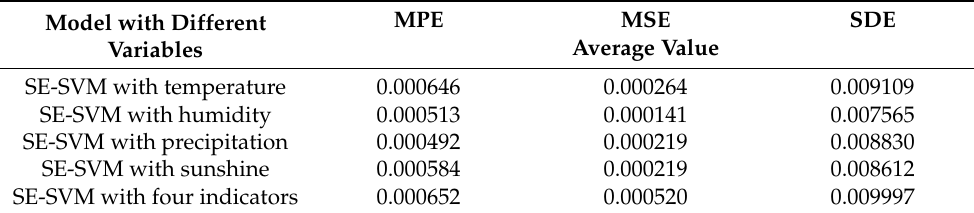
Table 3. Forecasting OWT using different model settings.